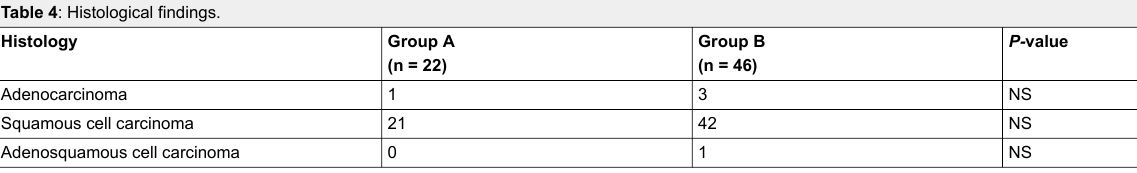
Table 4 : Histological findings.